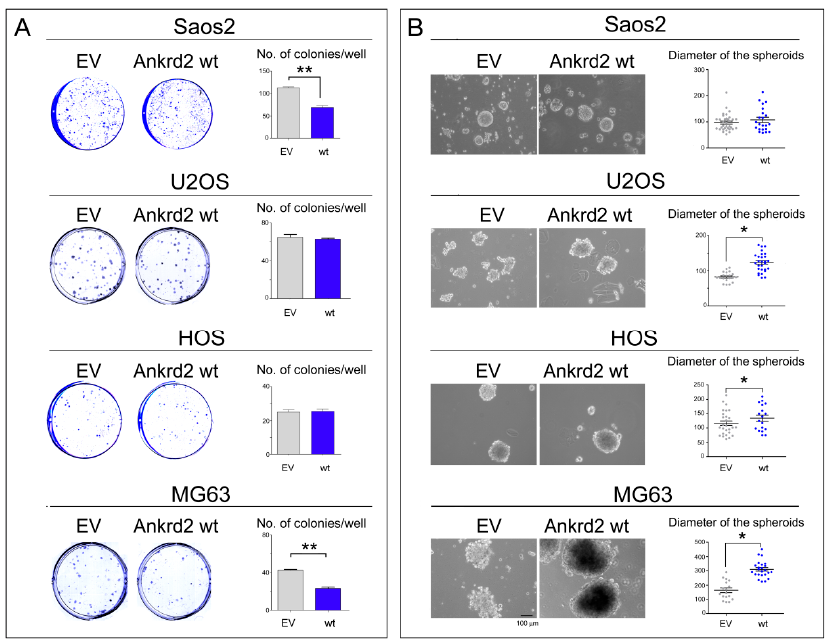
Figure 5. Ankrd2 overexpression affects clonogenicity of OS cell lines. ( A ) 1.2 × 10 2 cells from Saos2, U2OS, HOS and MG63 clones overexpressing Flag-Ankrd2wt, or that were transfected with empty vector (EV), were plated in multi-well plates and allowed to grow for two weeks. Colonies with >50 cells were counted and graphed using the GraphPad Prism software. Statistical analysis was performed using an unpaired two-tail Student’s t test. ** p < 0.001. ( B ) Saos2, U2OS, HOS and MG63 clones were seeded at a density of 2 × 10 5 cells/35 cm 2 culture dish in complete media containing methyl-cellulose onto a layer of 0.8% agar and allowed to grow. Spheroids were observed under light microscopy, and the diameter of spheroids (reported in µ m) composed of >50 cells were measured by AxioVision software and graphed into a vertical scatter plot using the GraphPad Prism software. The bar is 100 µ m. Statistical analysis was performed with a two-tail Student’s t -test. * p <